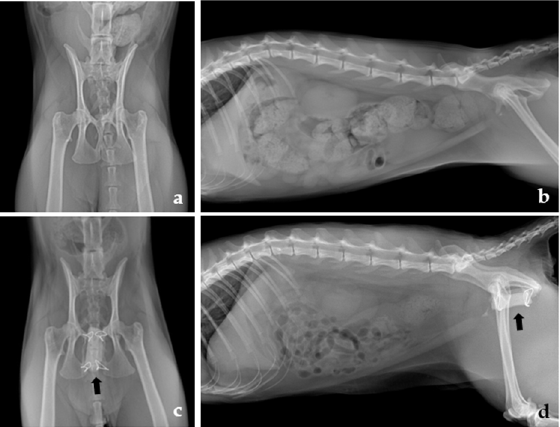
Figure 1. Preoperative ventrodorsal and lateral radiographs of the pelvis ( a , b ). There is colonic distention with feces and pelvic canal stenosis. Postoperative ventrodorsal and lateral radiographs of the pelvis ( c , d ) showing a polymethyl methacrylate spacer (black arrow) placed in the symphyseal osteotomy and the distracted pelvis 40 days after surgery with no colonic